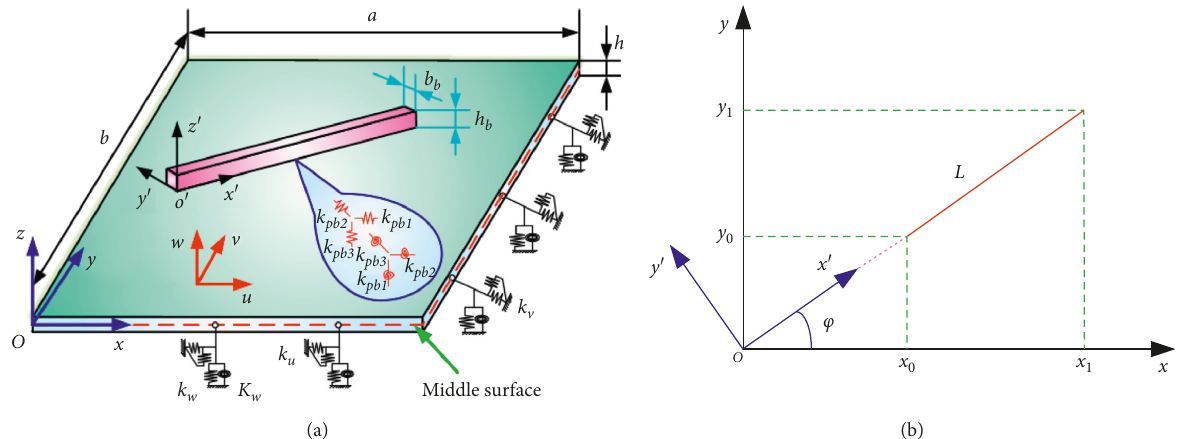
Figure 1: Schematic diagram of the coupling systems. (a) Geometry of rectangular plate reinforced by arbitrarily orientated beams. (b) Schematic of an arbitrarily placed